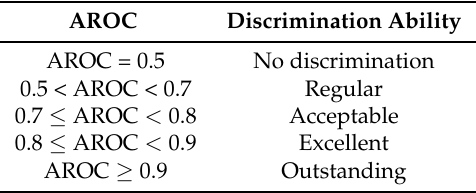
Table 6. Assessment rules of AROC.